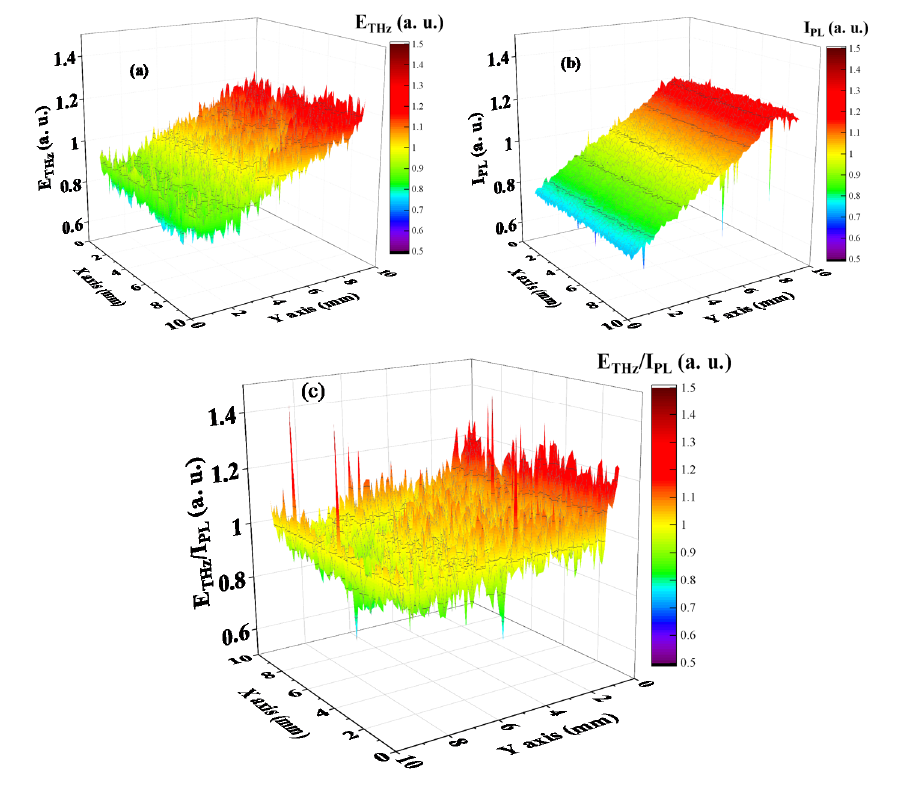
Figure 7. ( a ) Laser THz emission microscopy (LTEM) image and ( b ) PL image. ( c ) is the distribution of the LTEM amplitude divided by the PL intensity.